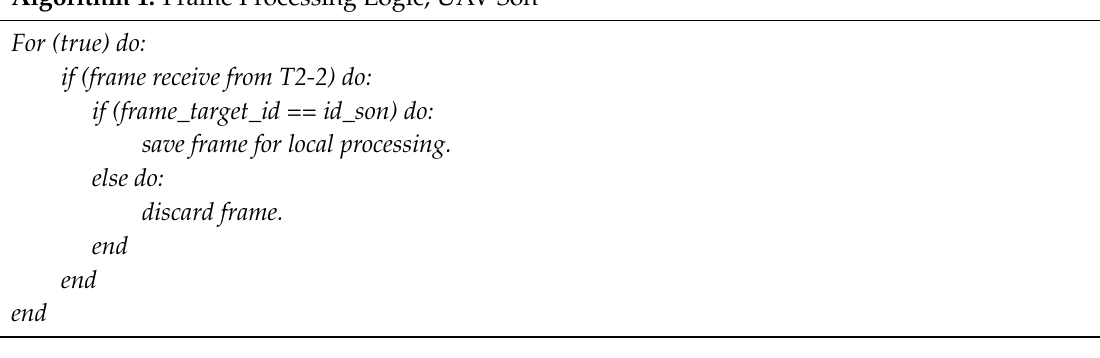
Algorithm 1: Frame Processing Logic, UAV Son